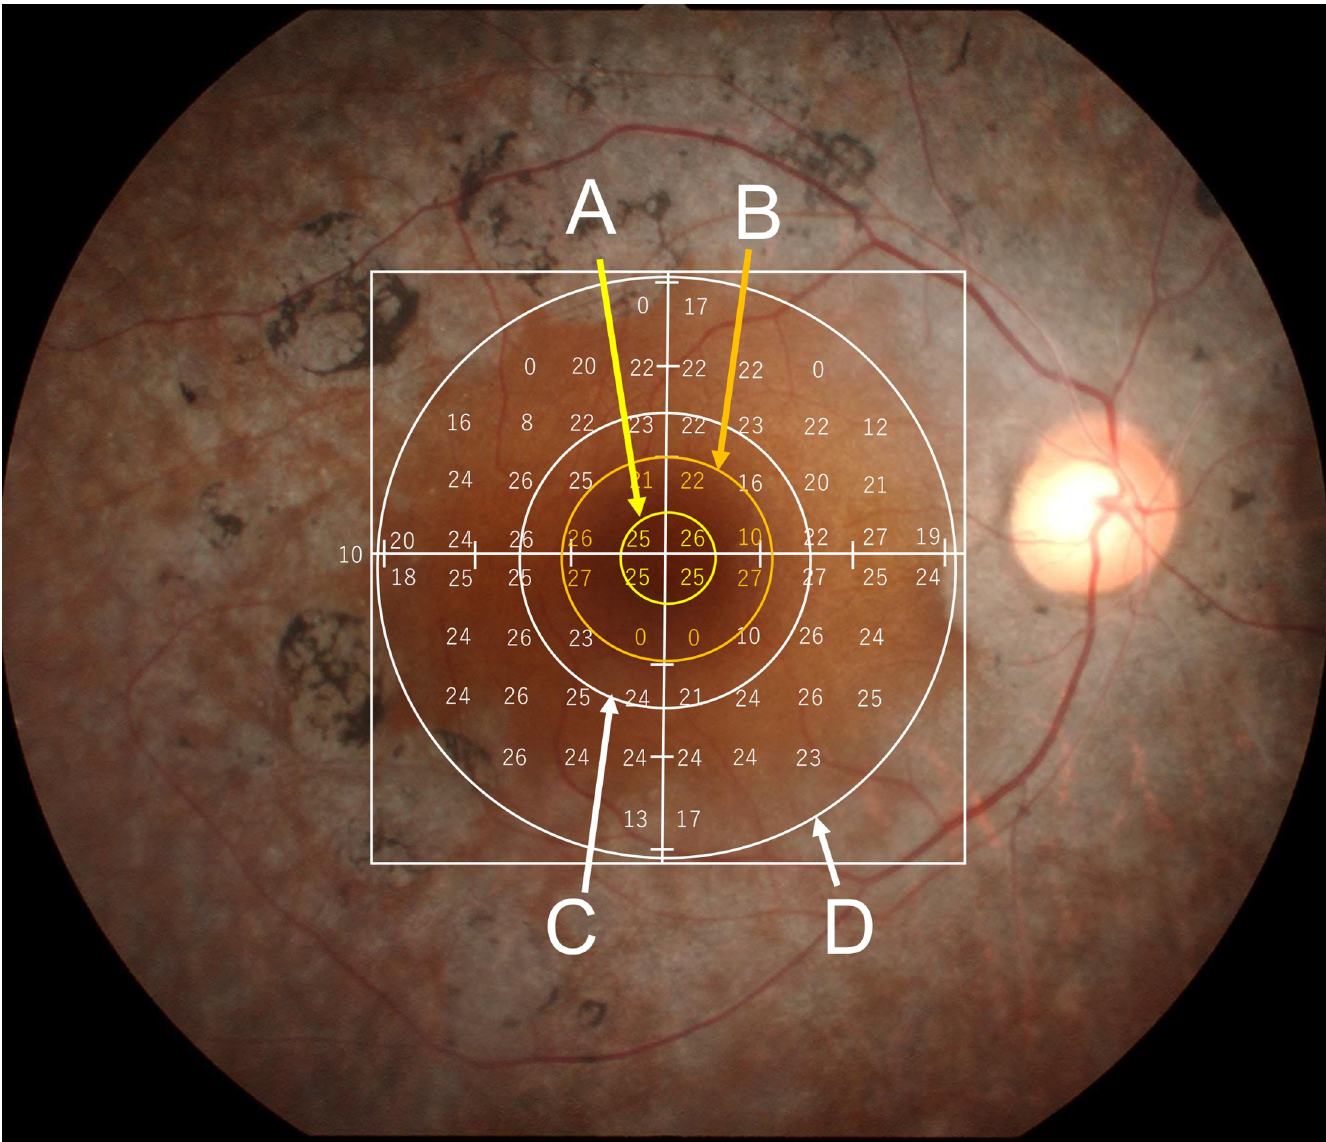
Fig 1. Fundus picture of a patient with RP overlaid by the same patient’s 10–2 plots of HFA and circles with radii of 1.0 mm (A), 2.2 mm (B), 3.0 mm (C) and 6.0 mm (D). An outermost squire is the macular cube (6 × 6 mm) of SD-OCT.